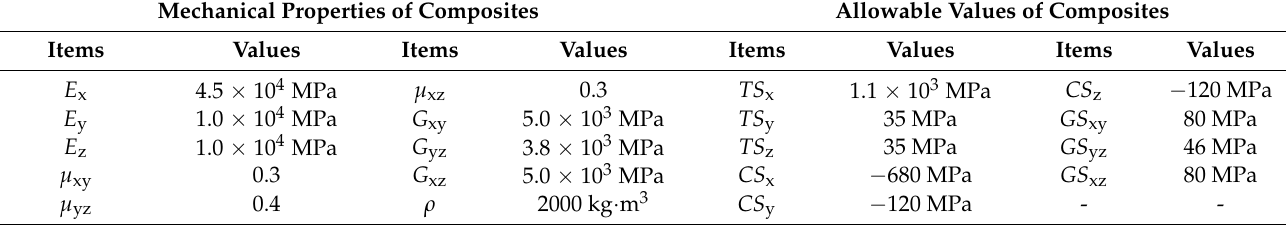
Table 1. Mechanical properties and allowable values.